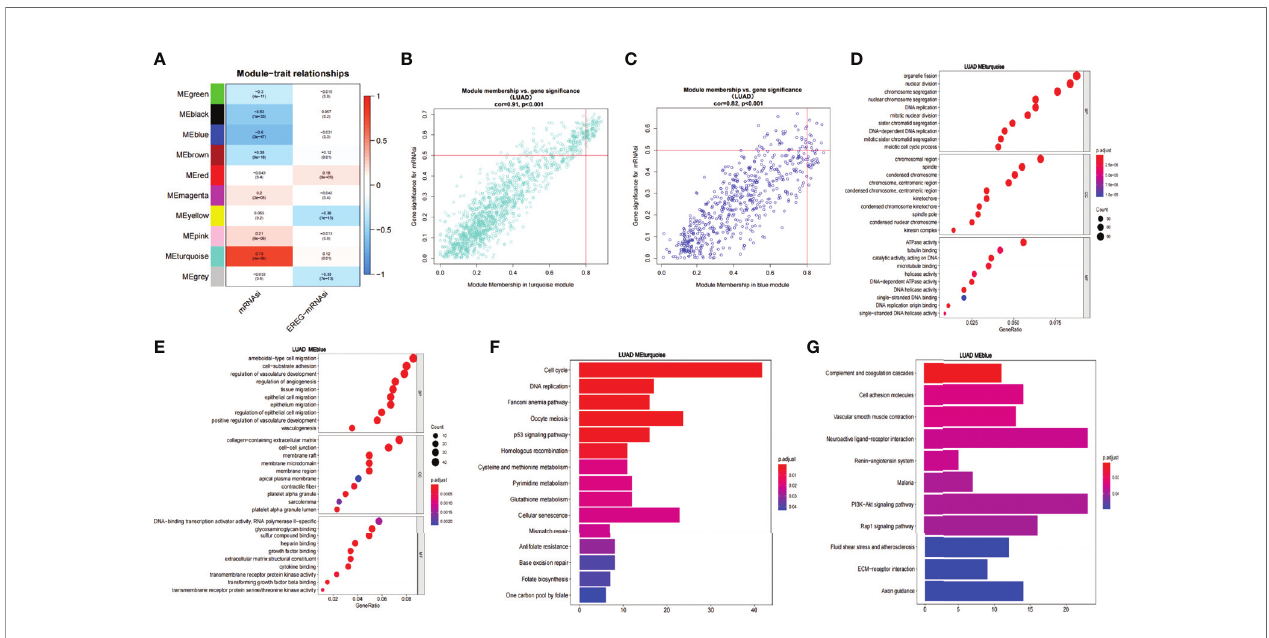
FIGURE 3 | WGCNA of LUAD and enrichment analysis of the signi fi cant modules. (A) Correlation of the gene module with mRNAsi and EREG-mRNAsi. (B, C) Scatter graph of the blue module (module membership vs. gene signi fi cance). Scatter graph of the turquoise module (module membership vs. gene signi fi cance). (D, E) . GO enrichment analysis of the blue and turquoise modules. (F, G) KEGG pathway enrichment analysis of the blue and turquoise